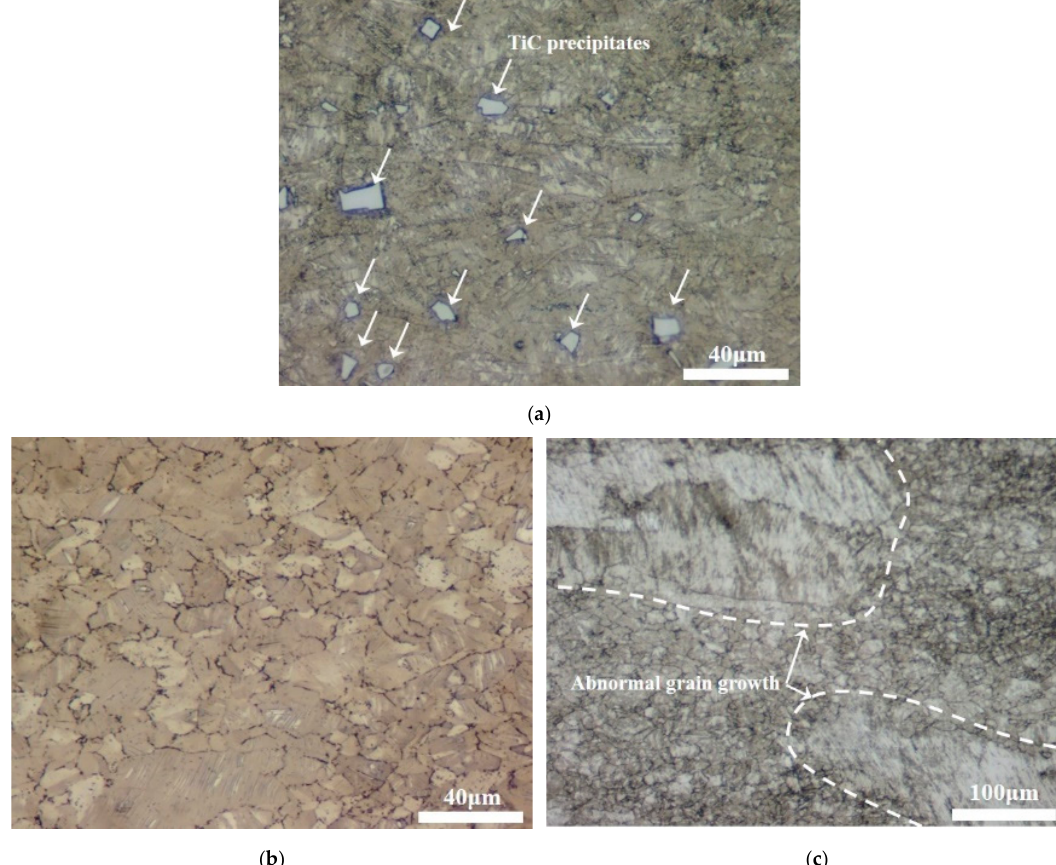
Figure 8. Optical micrographic image. ( a ) A-type; ( b ) B-type; ( c ) abnormal grain growth in B-type.